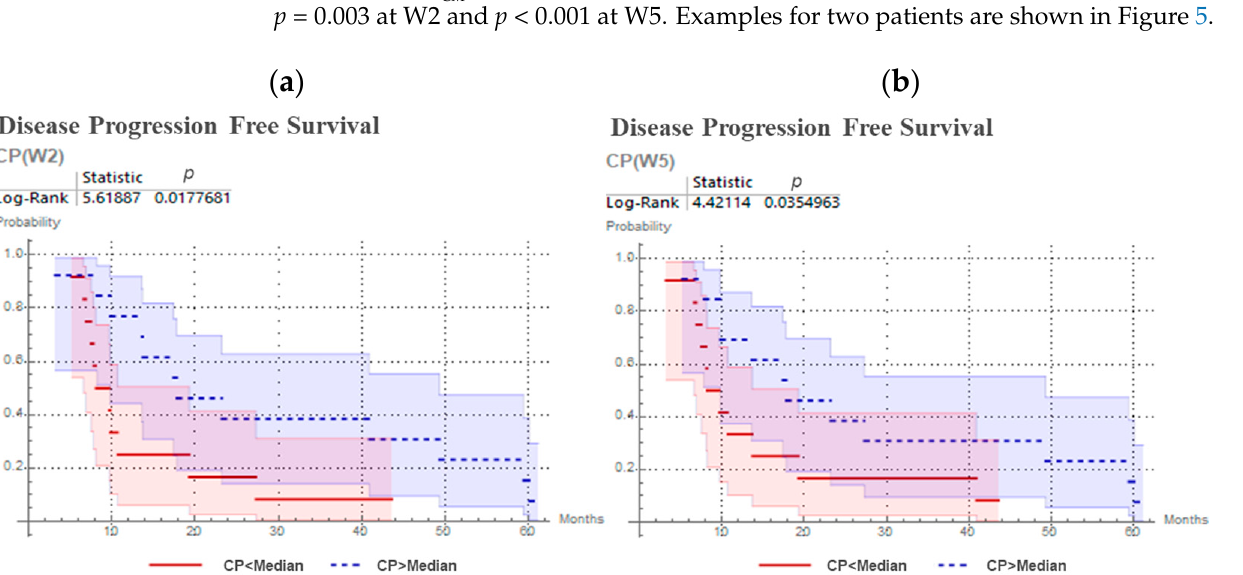
Figure 3. Kaplan–Meier curves and log-rank test for CP predicting progression free survival for head and neck cancer patients, with 18F-FMISO PET/CT at second week ( a ) and at fifth week ( b ) of chemoradiotherapy.